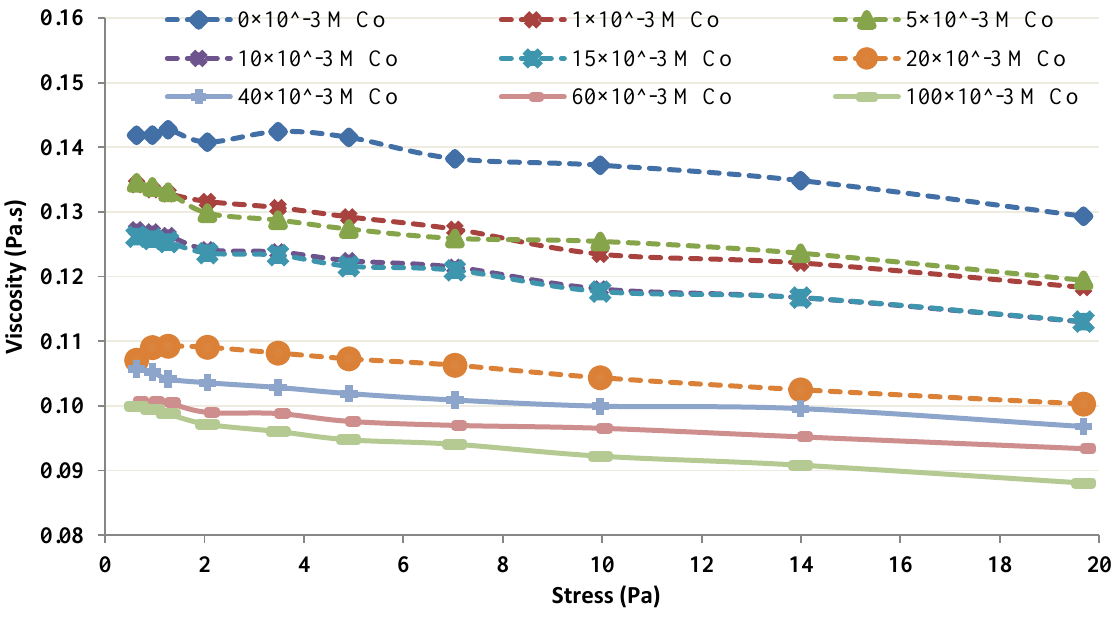
Figure 14. 20 g/L Chitin’s Rheological behavior.